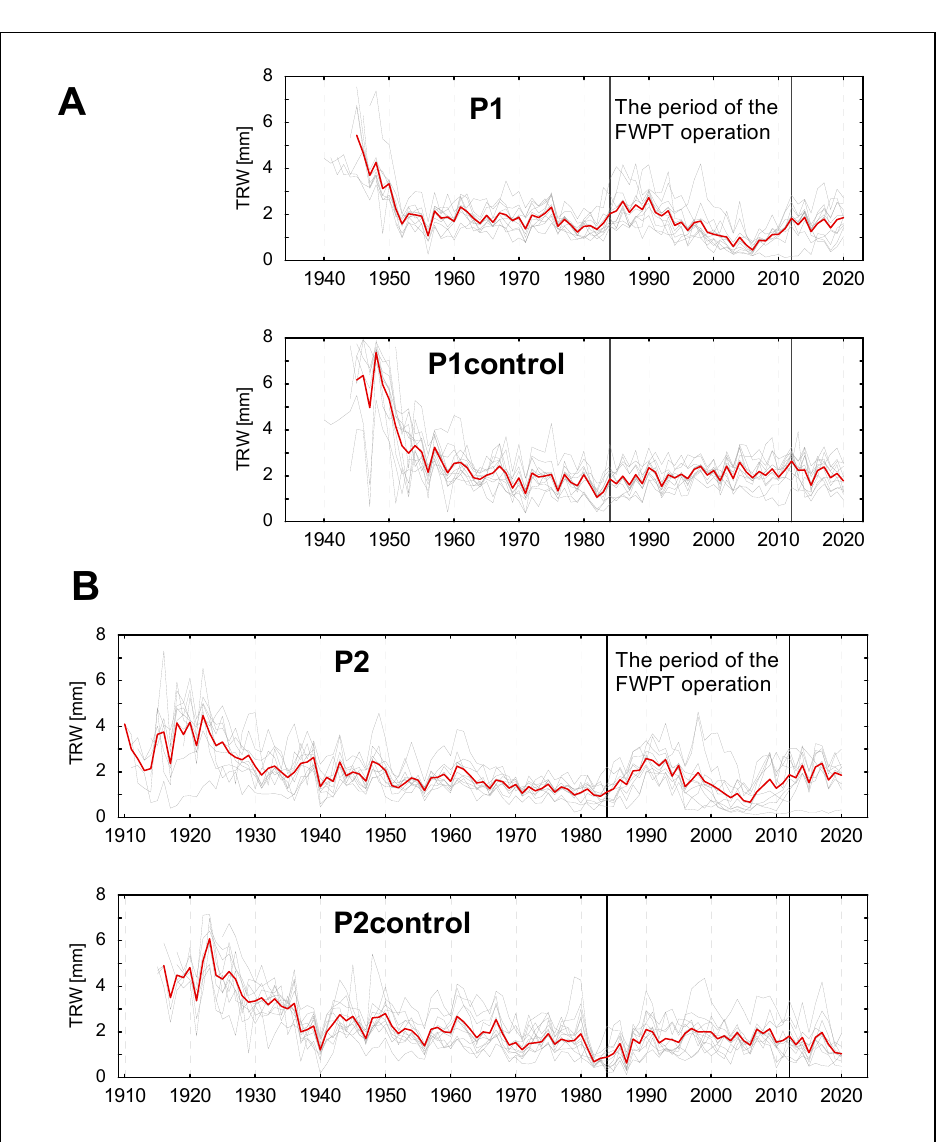
Figure 4. Sequences of tree-ring width (TRW) Scots pine growing on the study plots (thin grey lines—individual series, thick red line—raw chronology); ( A )–for younger trees (P1 and P1 control plots); ( B )–for older trees (P2 and P2 control plots). The vertical lines indicate the period of operation of the Forest Wastewater Treatment Plant [FWTP].